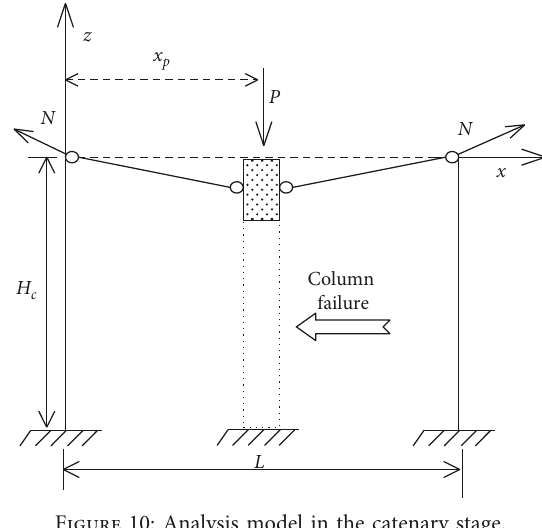
Figure 10: Analysis model in the catenary